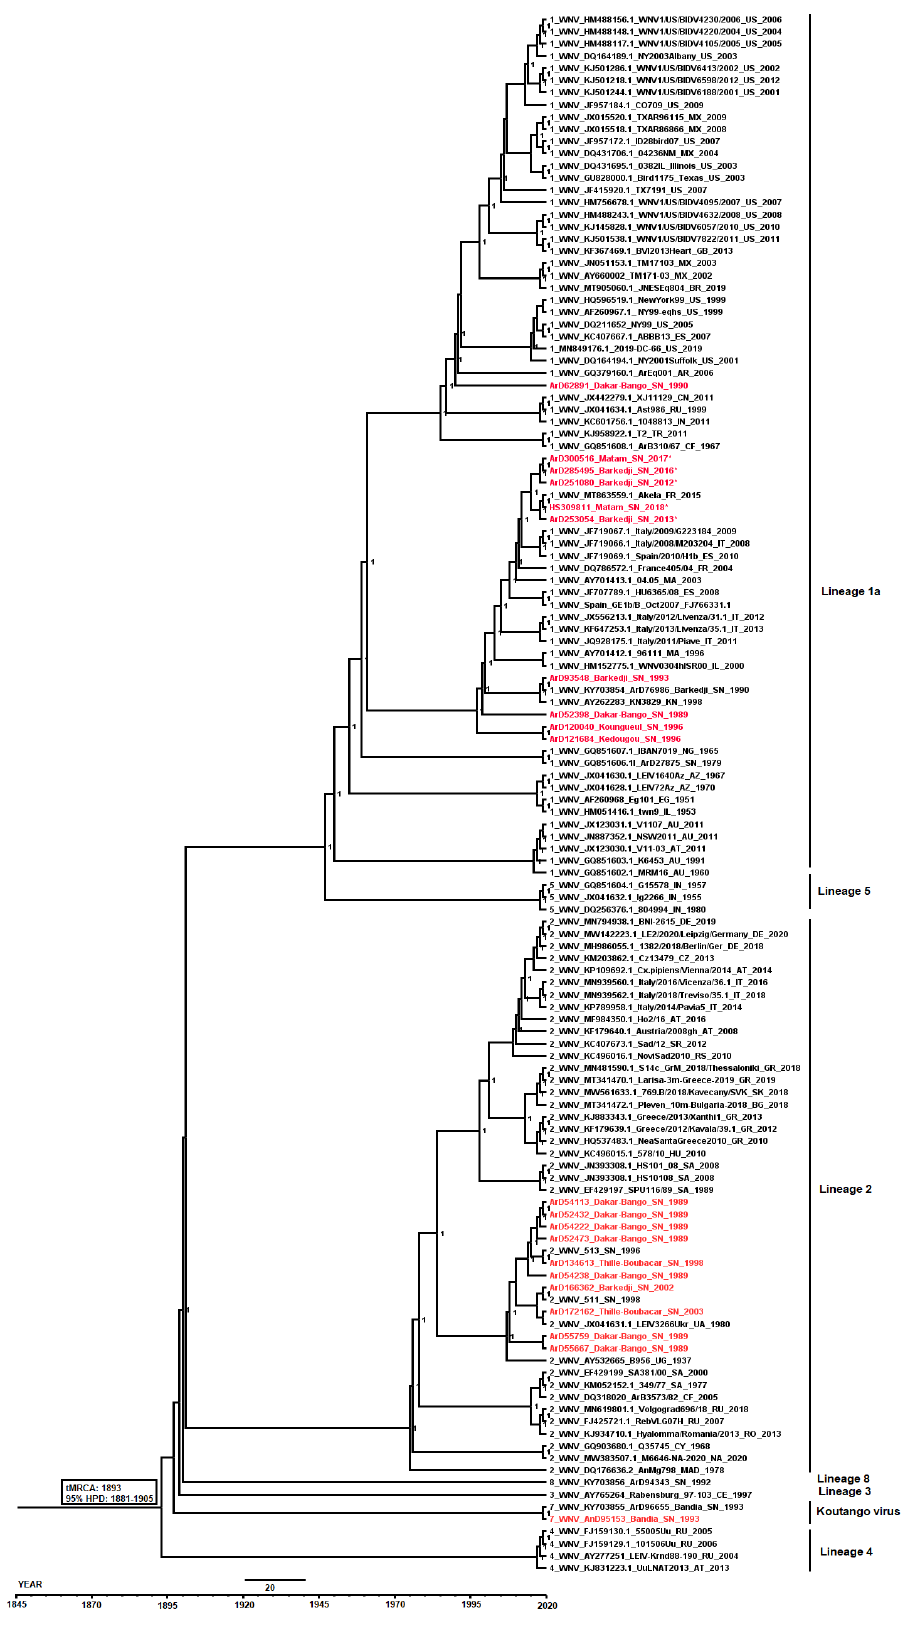
Figure 6. Bayesian maximum clade credibility tree estimating the phylogenetic relationships of West Nile virus including recent sequences from Senegal between 1989 and 2018. Tree nodes were supported by posterior probability values. The Senegalese West Nile virus sequences are colored